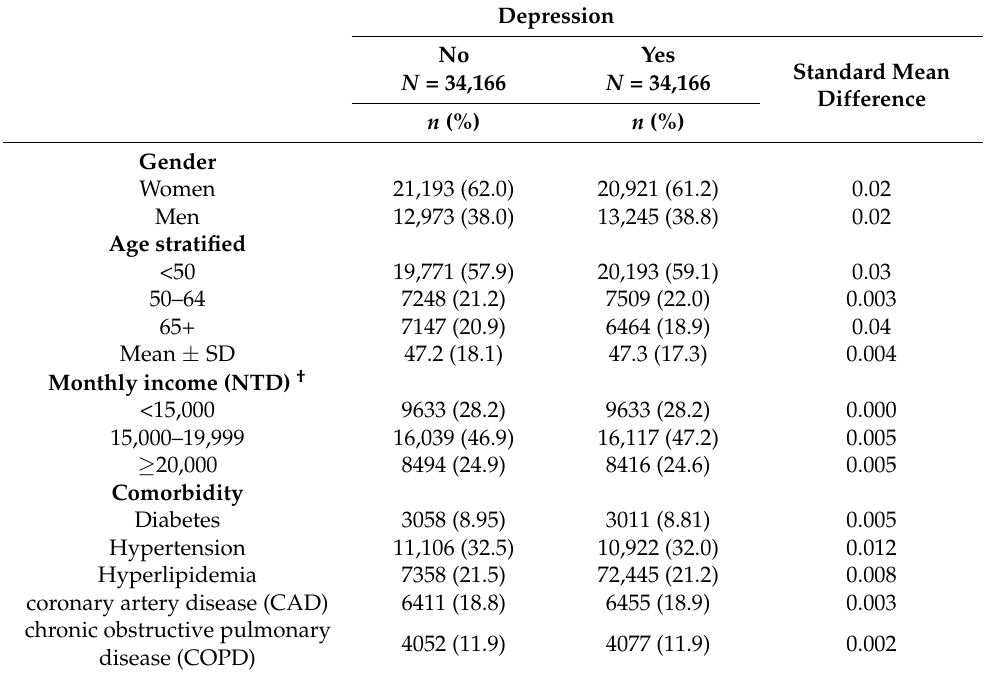
Table 1. Comparisons in demographic characteristics and comorbidities between cohorts with and without